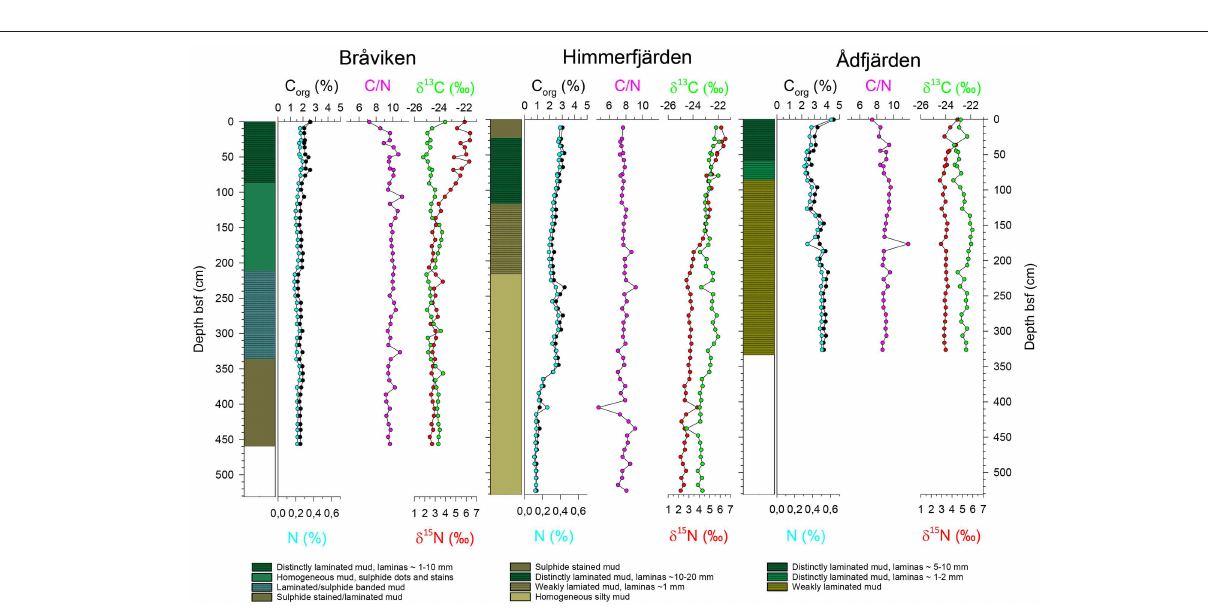
taxa as in Him 1A but with slightly higher relative abundances